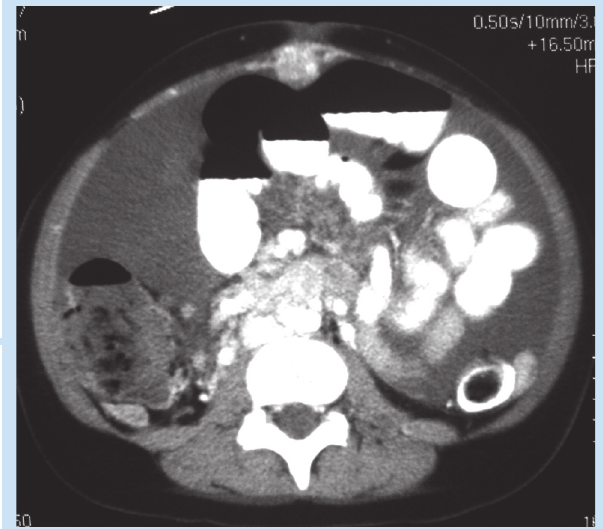
Fig. 1. Axial postcontrast CT of the abdomen – Sister Mary Joseph nodule. Also note the presence of subserosal and peritoneal